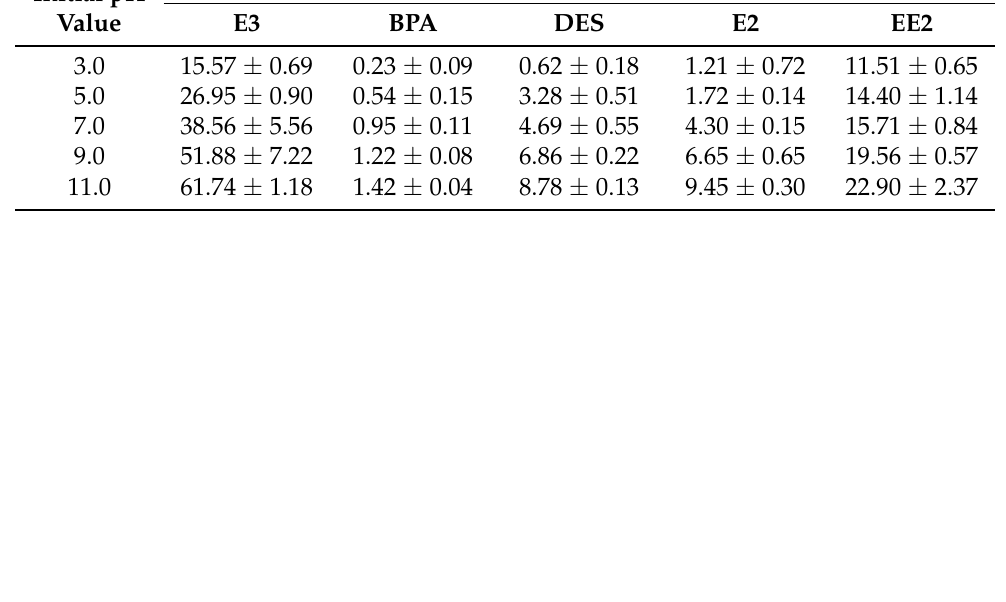
Table 5. Effect of initial pH on the residual concentrations of estrogens in cow manure by the Fenton oxidation process. Note: the Fe(II) to H 2 O 2 molar ratio was 0.10 M/M; the H 2 O 2 dosage was 2.56 mmol/g; the solid to water mass ratio was 2 g/mL; the reaction time was 24 h. Initial pH Value